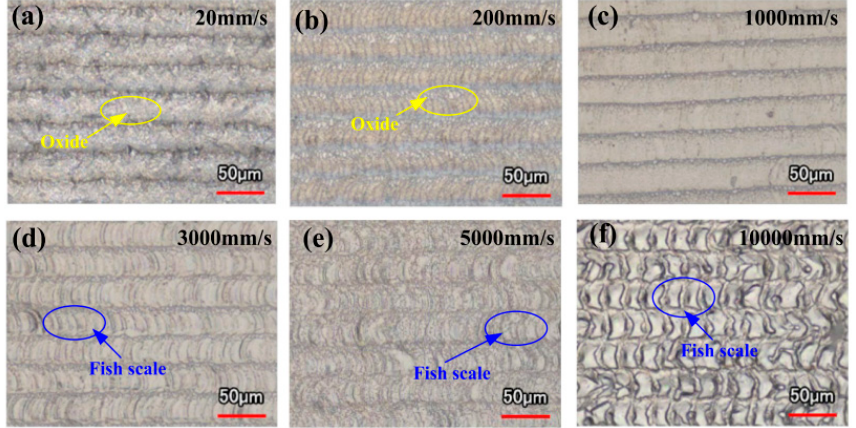
Figure 6. Morphology of a laser-cleaned surface with different scanning velocities [50]. ( a ) 20 mm/s; ( b ) 200 mm/s; ( c ) 1000 mm/s; ( d ) 3000 mm/s; ( e ) 5000 mm/s; ( f ) 10,000 mm/s.